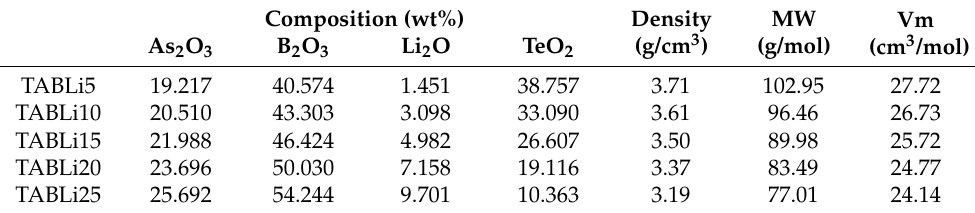
Figure 1. The Monte Carlo MCNP 3D simulation geometry is used in the present work. Table 1. The chemical composition of the investigated glass